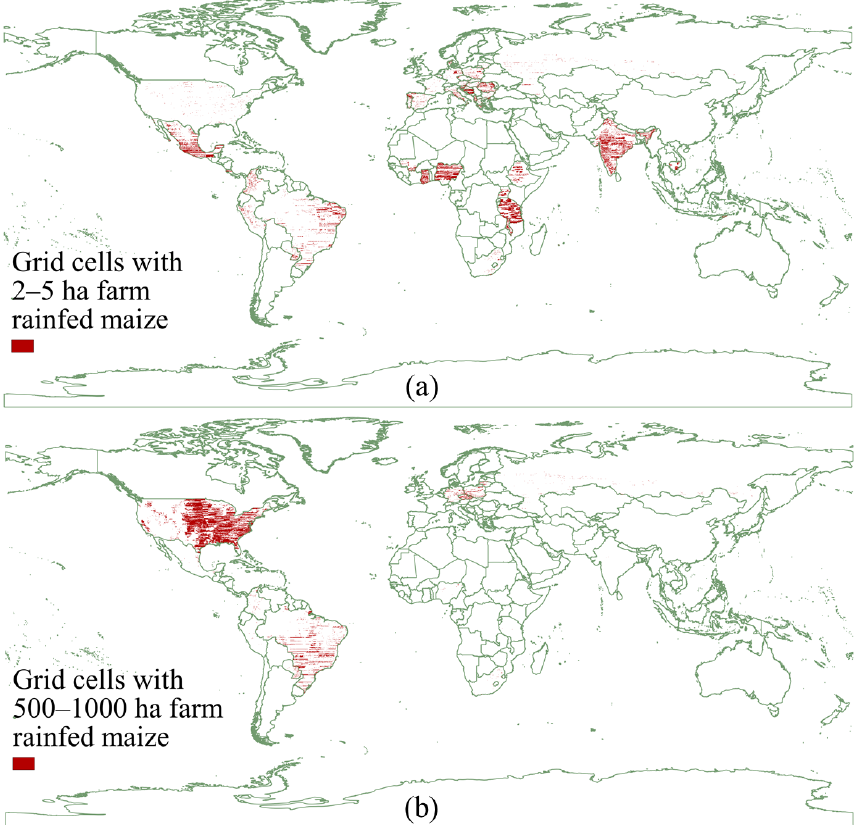
Figure 2. Grid cells with a harvested area of rainfed maize on farm size 2–5ha (a) and farm size 500–1000ha (b) , according to our farm- size-specific and crop-specific dataset based on the GAEZv4 crop